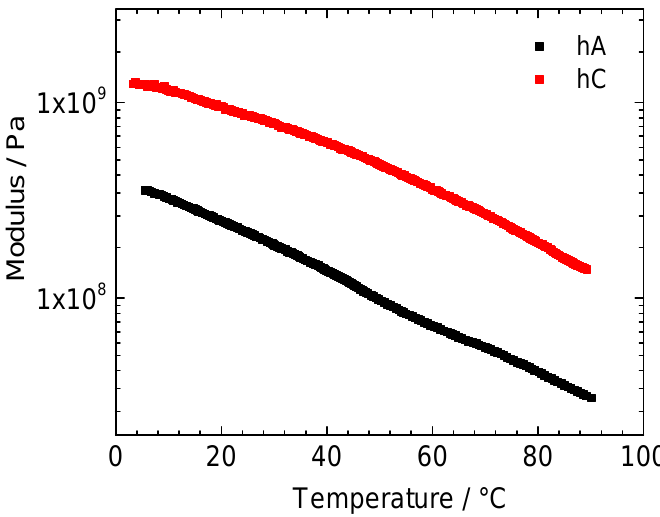
Figure 5. Temperature dependence of the storage modulus of vacuum-dried hA (black) and hC (red).